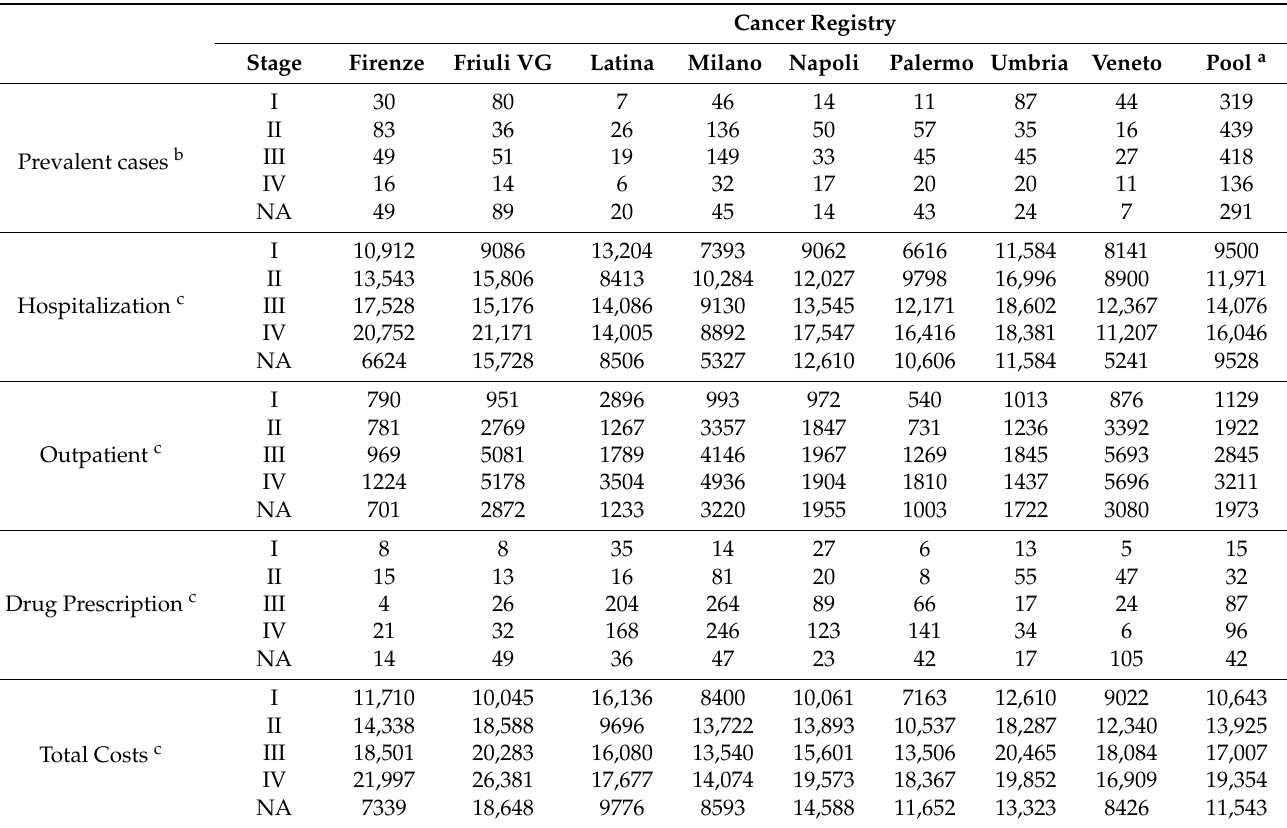
Table 4. Prevalent cases in initial phase by stage at diagnosis and patient annual average costs in initial phase by stage at diagnosis and type of service.